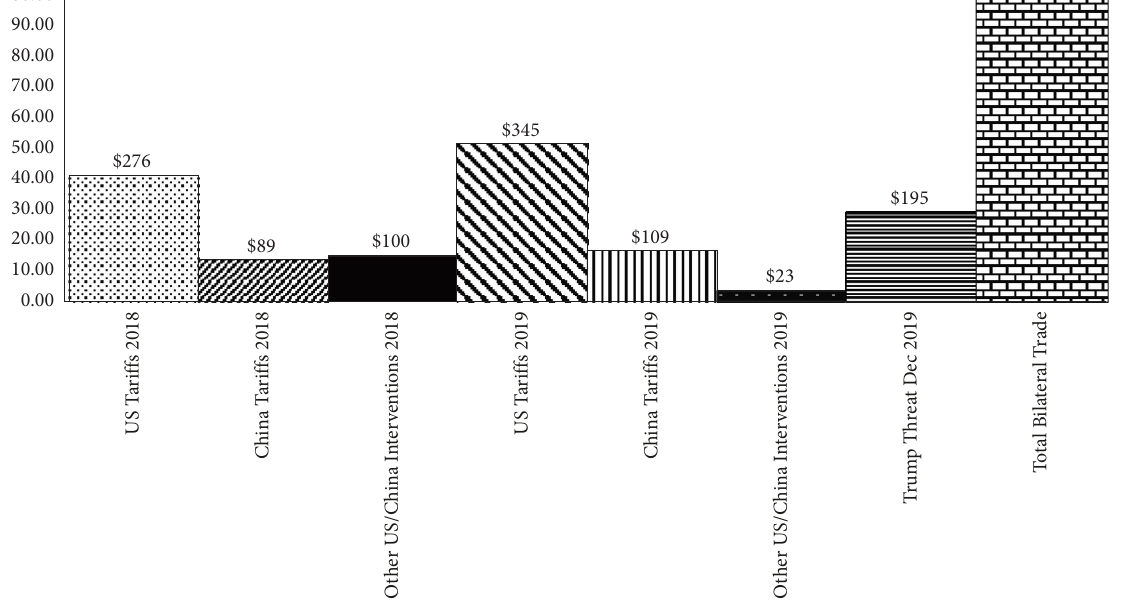
Figure 7: Share of the Sino-US trade war in total bilateral trade. Source: Evenette Table 3: Te variables used in the model.